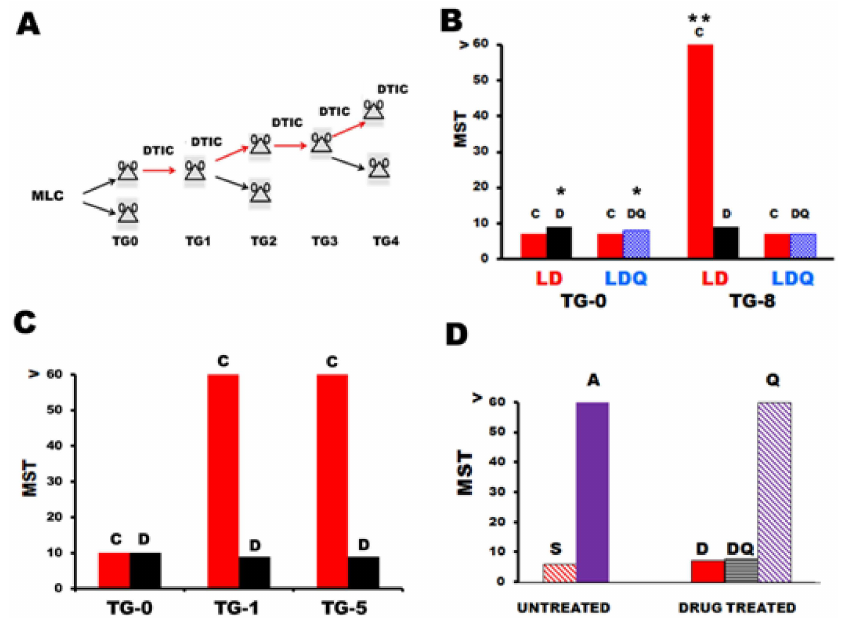
Figure 2. DTIC-induced xenogenization. Quinacrine interferes with DTIC-induced xenogenization, but not with the antitumor or immunosuppressive activity of this drug, or with the onset of resistance to the triazene compound. ( A ) Graphic protocol showing the treatment scheme utilized to expose in vivo mouse leukemia cells (MLC) to DTIC (100 mg/Kg ip, day 1–5, [178]) in the course of sequential transplant generations (TGs). At each TG recipient mice were left untreated or treated with DTIC for the subsequent TG. ( B ) Co-administration of DTIC + quinacrine abrogates the DIX effect afforded